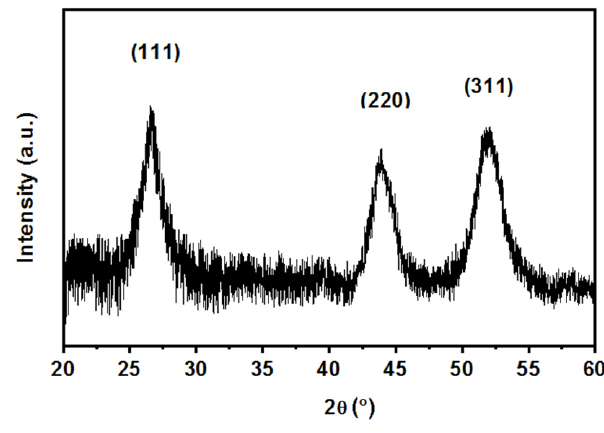
Figure 4. XRD pattern of cadmium sulfide nanoparticles.